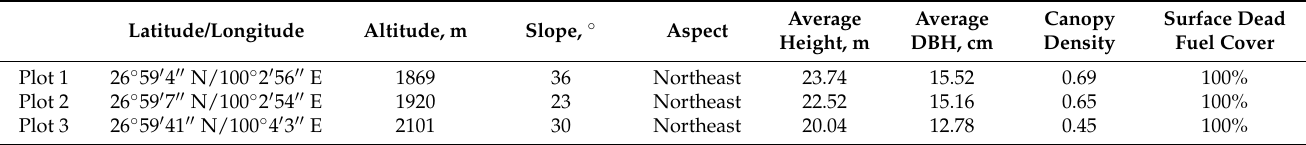
Table 1. Characteristics of the P. yunnanensis forest